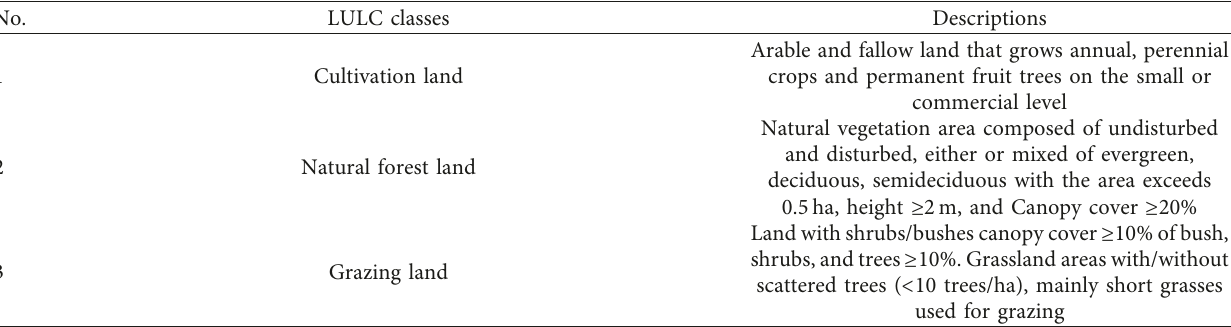
Figure 3: Maps showing slope classes, soil sampling points, and soil mapping units of Geshy subcatchment. Table 1: Description of land use types identified in the Geshy Subcatchment,